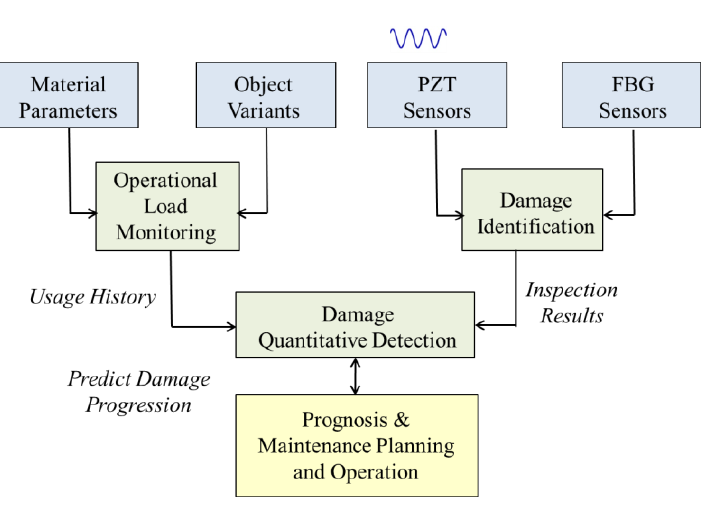
Figure 1. System architecture of SHM [34].